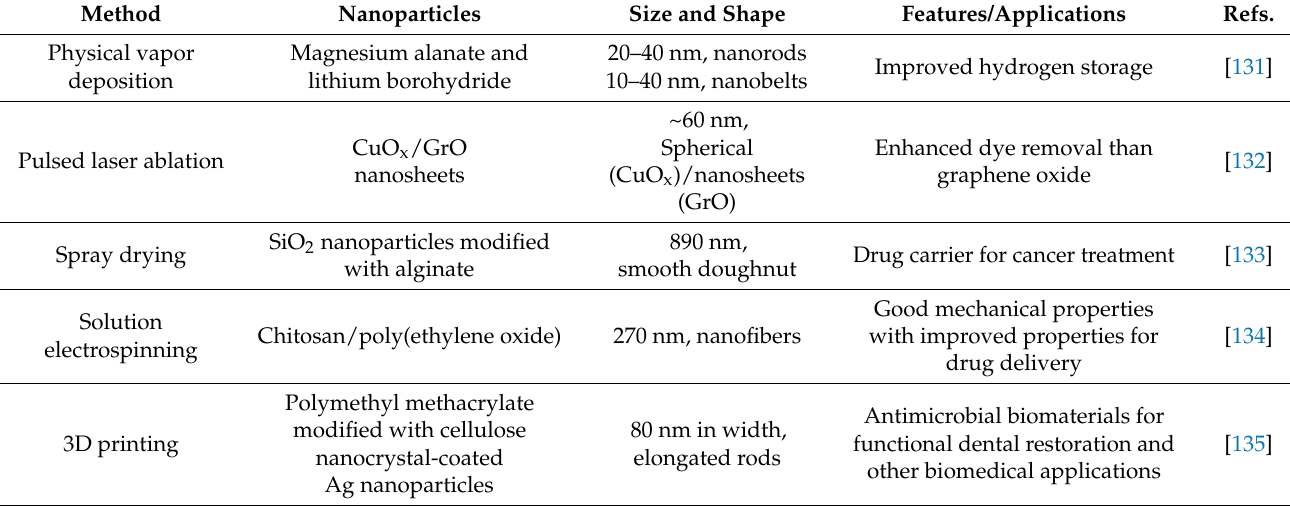
Table 2. Physical methods used to synthesize nanoparticles and